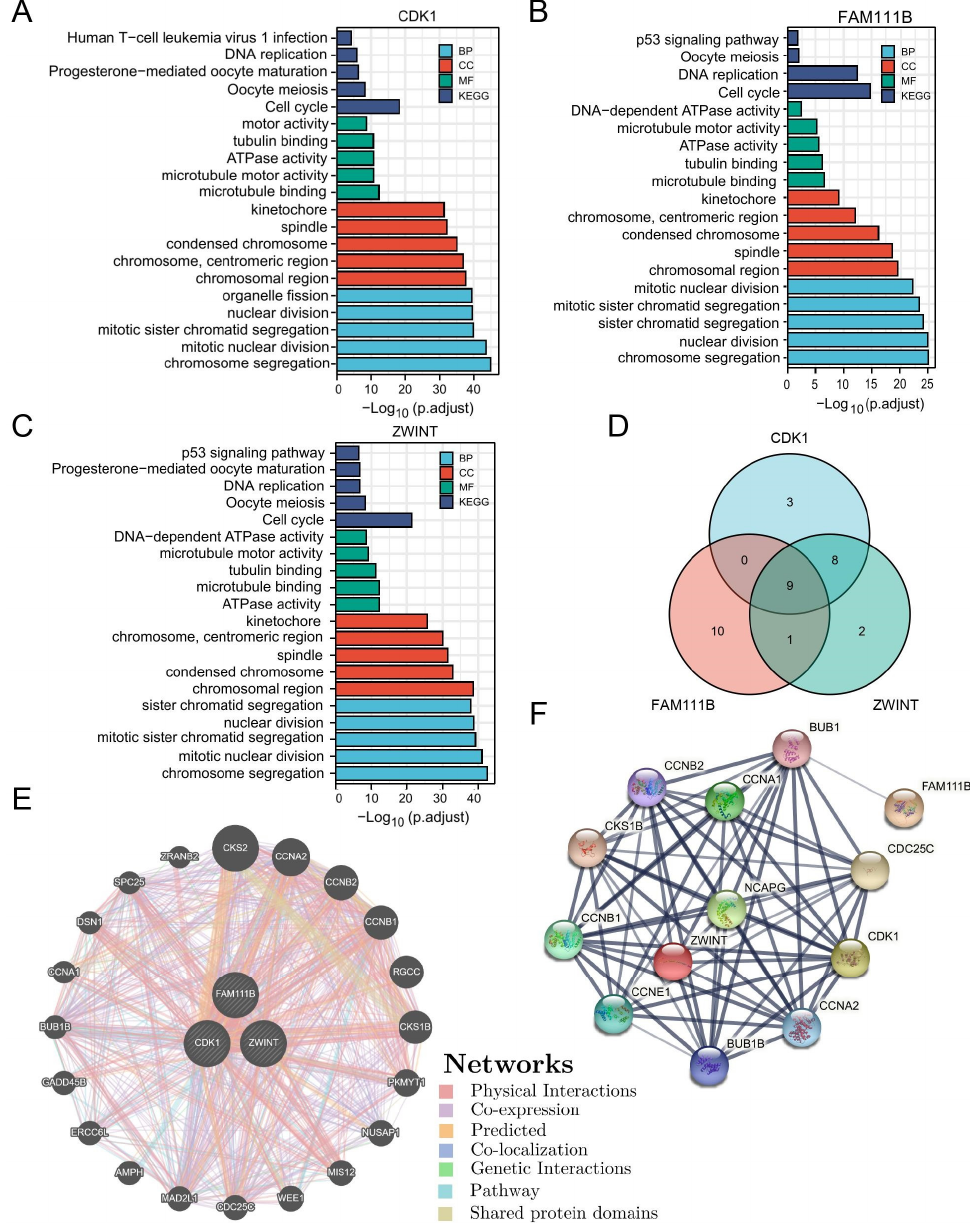
Figure 4. GO and KEGG enrichment analysis and interaction networks. ( A – C ) GO and KEGG enrichment analysis of ( A ) CDK1, ( B ) FAM111B, ( C ) ZWINT. ( D ) Venn diagram of CDK1, FAM111B and ZWINT related pathways. ( E ) Functional association networks of CDK1, FAM111B and ZWINT. ( F ) Top 10 protein interaction networks of CDK1, FAM111B and ZWINT; line thickness indicates the strength of data support.